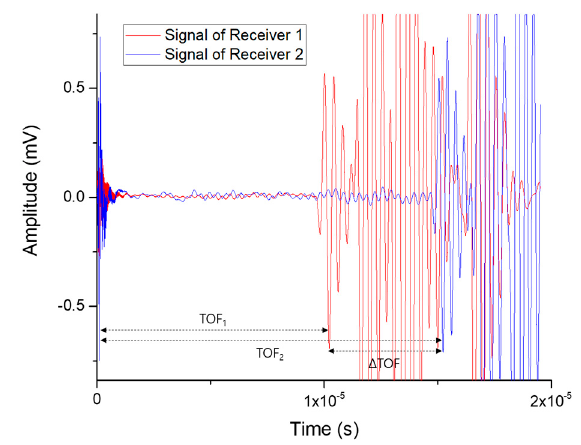
Figure 8. Received signals used for calculating travel times.